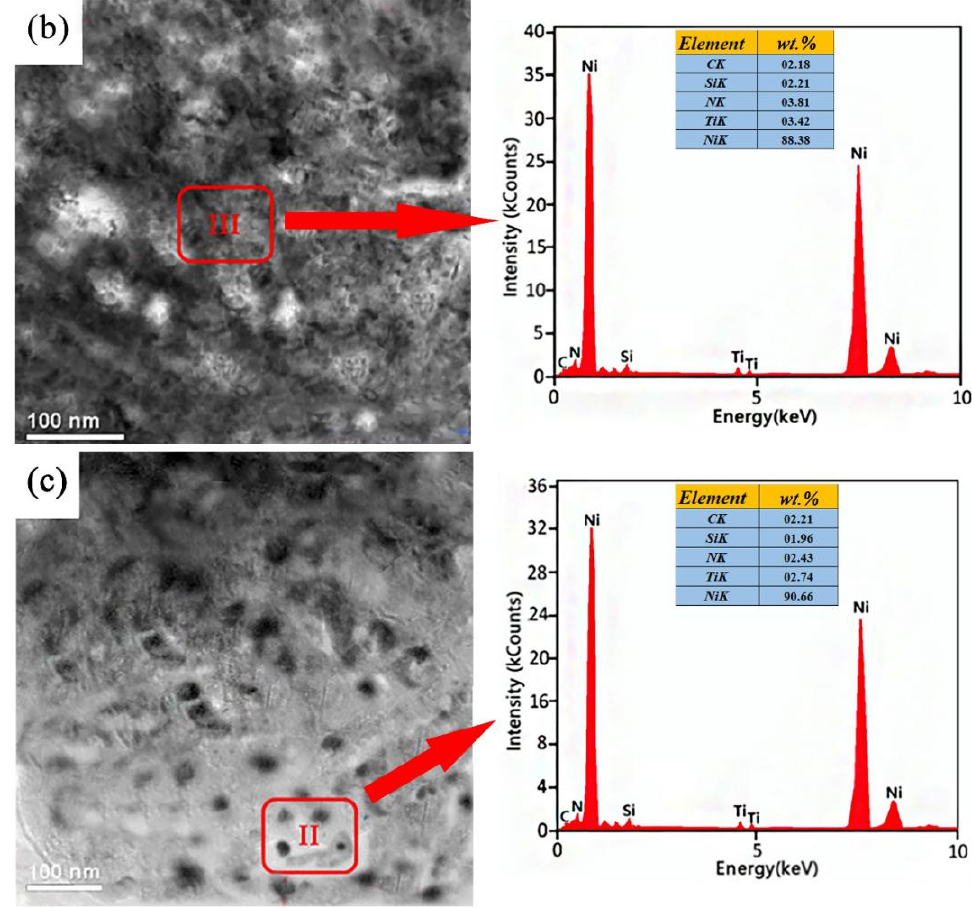
Figure 4. Micrographs of TEM for Ni/TiN-SiC nanocomposites fabricated using various current densities: ( a ) 2 A/dm 2 , ( b ) 4 A/dm 2 , and ( c ) 6 A/dm 2 .